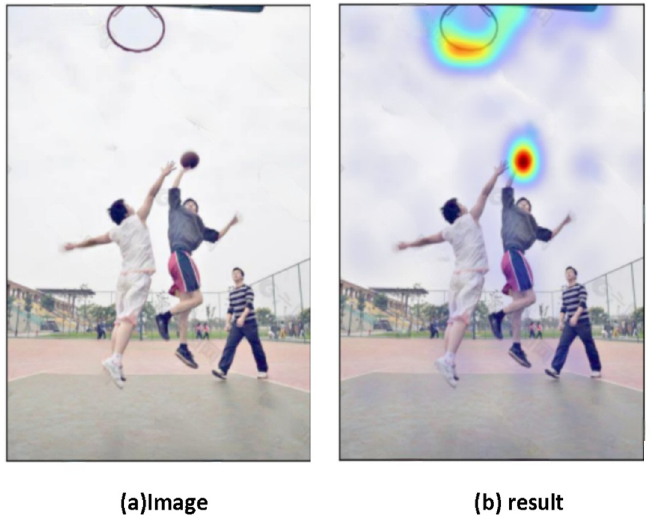
Figure 7. By using an external knowledge base to update knowledge, our model has the ability to reason and judge more broadly. ( a ) is the original picture. As the word basketball is input, our model will detect basketballs and basketball-related items, i.e., the basket. This proves that with the assistance of the knowledge base, our model has the ability to judge and classify